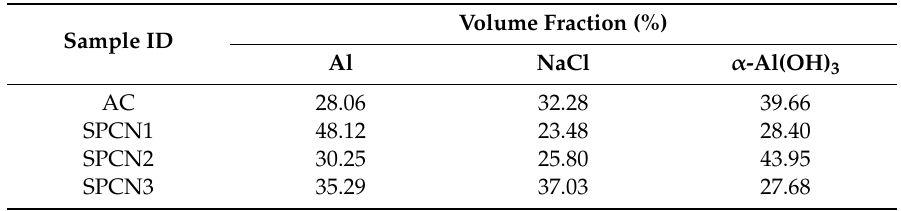
Table 6. Volume fraction (%) of phases present on corrosion products after 89 days of exposure in 3.5 wt.% NaCl